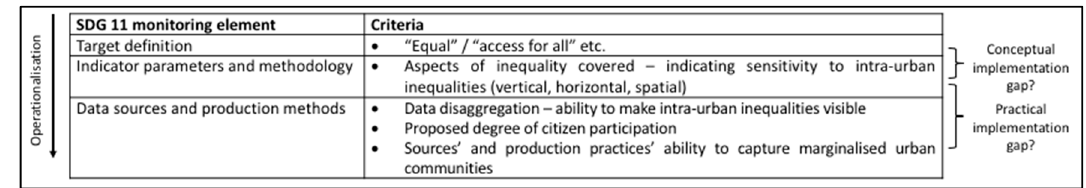
Figure 2. The methodological approach.